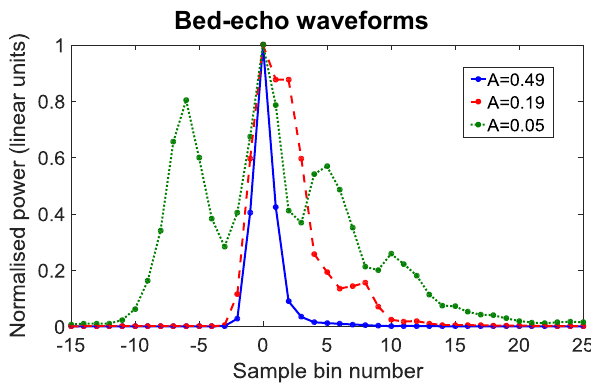
Figure 4. Examples of bed-echo waveforms and their abruptness (pulse peakiness). Observed values for A range from ∼ 0.03 (asso- ciated with diffuse scattering) to ∼ 0.60 (associated with specular reflection). For the purpose of comparative plotting, the waveforms are normalised about their peak power values with the sample bin of the peak power set to zero. The sample bin spacing corresponds to a depth-range spacing of ∼ 2.81m in